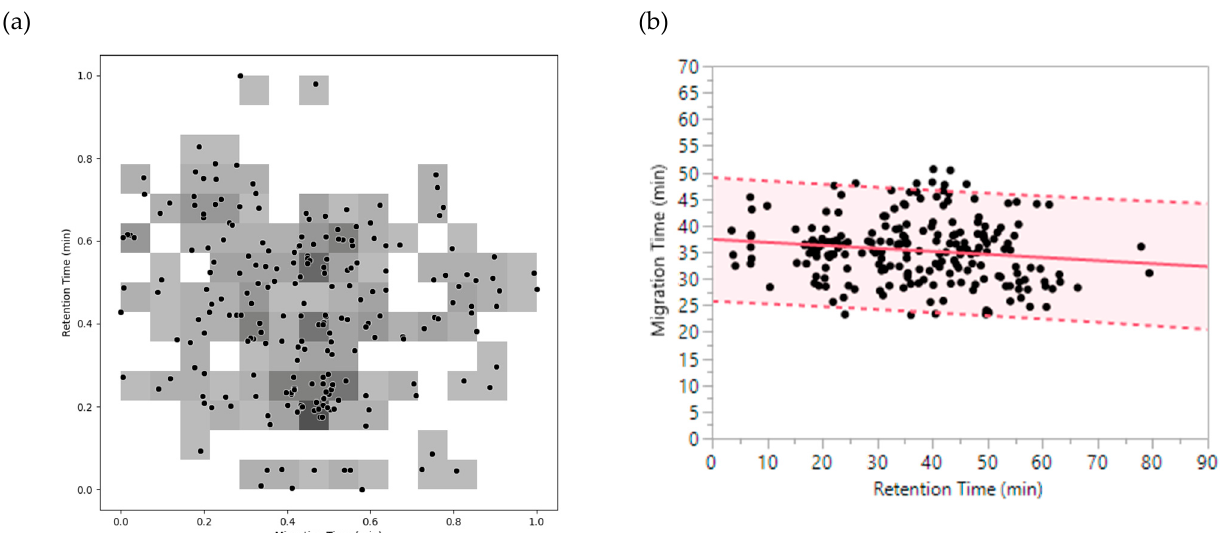
Figure 4. Orthogonality between RPLC-Chip and CZE using methods 1 and 2. ( a ) Method 1: Plot illustrating the coverage of the separation space by peptides through shaded bins. ( b ) Method 2: Plot illustrating the distribution of peptides around linear regression. The pink section indicates the separation space occupied by peptides.